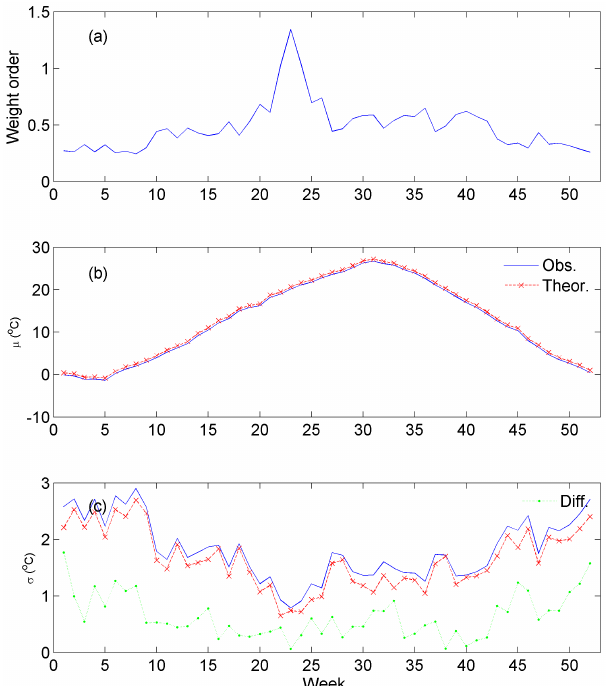
Figure 7. (a) Estimated weight order from HS and weekly statis- tics of (b) mean and (c) variance for the observed temperature data (solid line) and the theoretical statistics (dashed line with cross) us- ing Eqs. (2) and (7), for Buan station. The weekly difference in variance between observation and theoretical (see Eq. 8) is shown in panel (c) by a dotted